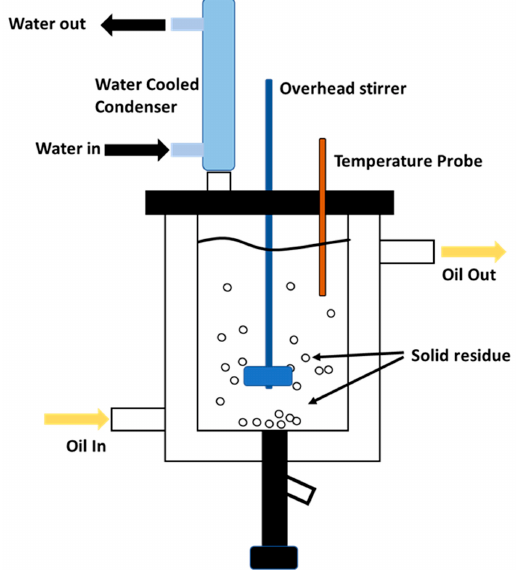
Figure 1. Schematic drawing of experimental